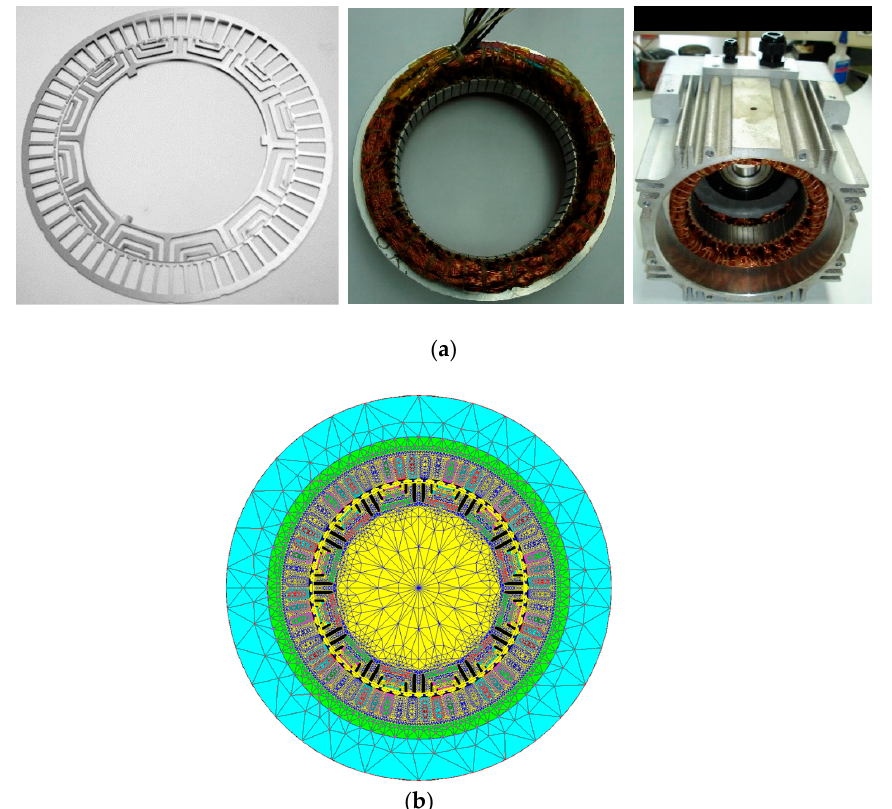
Figure 2. ( a ) The experimental machine. ( b ) The mesh of the fPMa-SynRM FEM model analyzed in this paper.